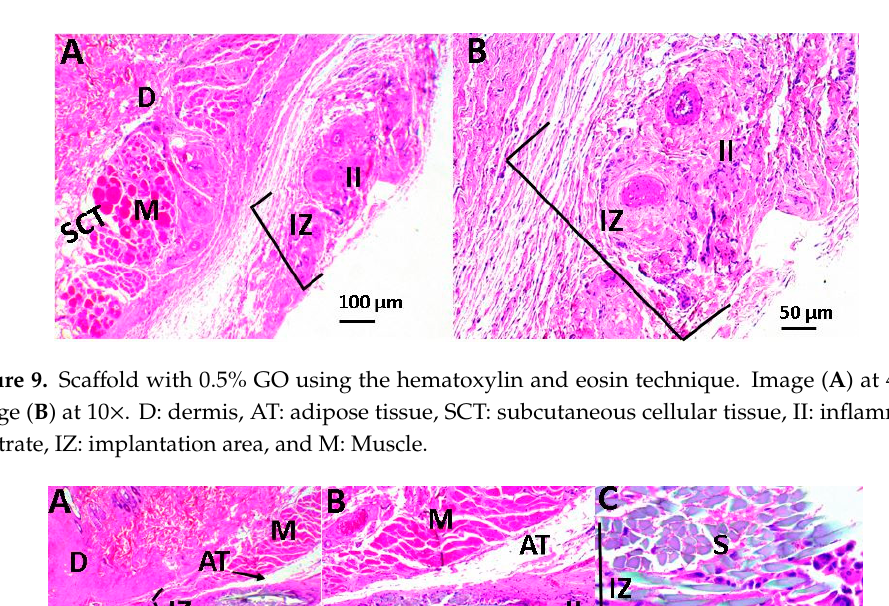
inflammatory infiltrate, IZ: implantation area, M: muscle, and FC: fibrous capsule.